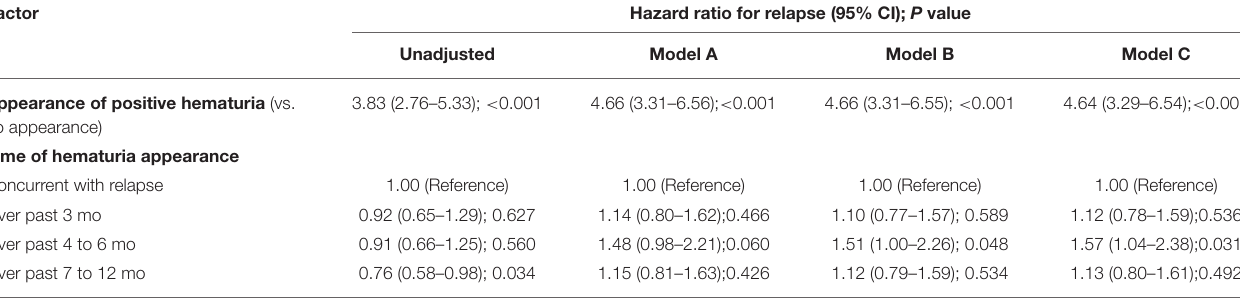
TABLE 3 | Worsening hematuria and risk of short-term relapse in cox proportional hazards models.